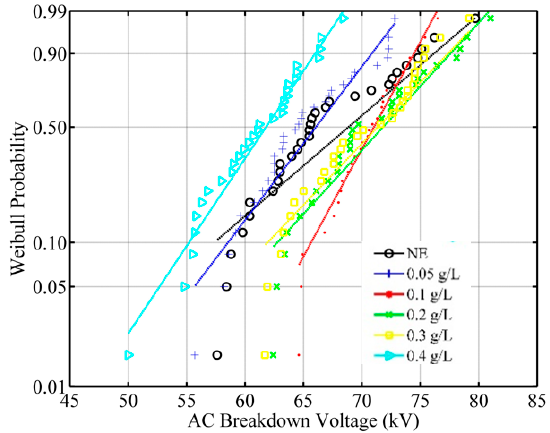
Figure 5. Weibull probability of NE and ZnO nanofluids for different concentrations.